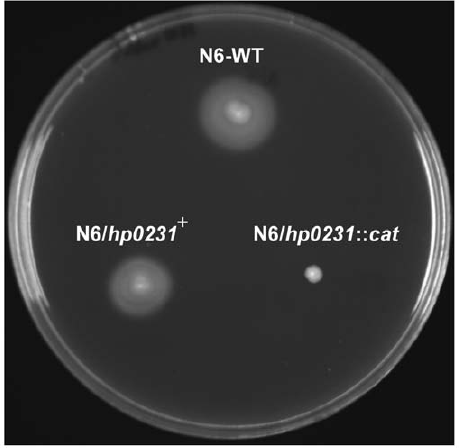
Figure 3. Motility of H.pylori N6 strains: wt, hp0231::cat and hp0231::cat complemented in trans by puWM397 ( hp0231 + ). Bacterial motility was monitored after 4 days of incubation on 0.3% MH- agar plates containing 10% FCS. The hp0231 mutant strain is non- motile.